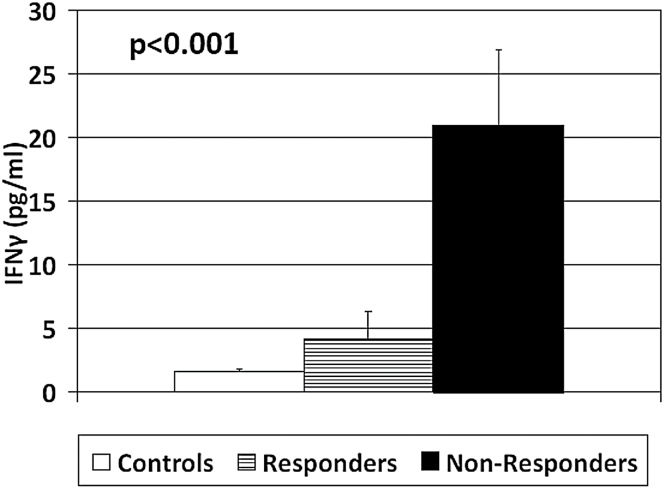
Baseline mean ± standard error of the mean interferon (IFN)-γ levels in Controls, Responders, and Non-Responders. P value indicates the significance of the comparison with the one-way ANOVA.